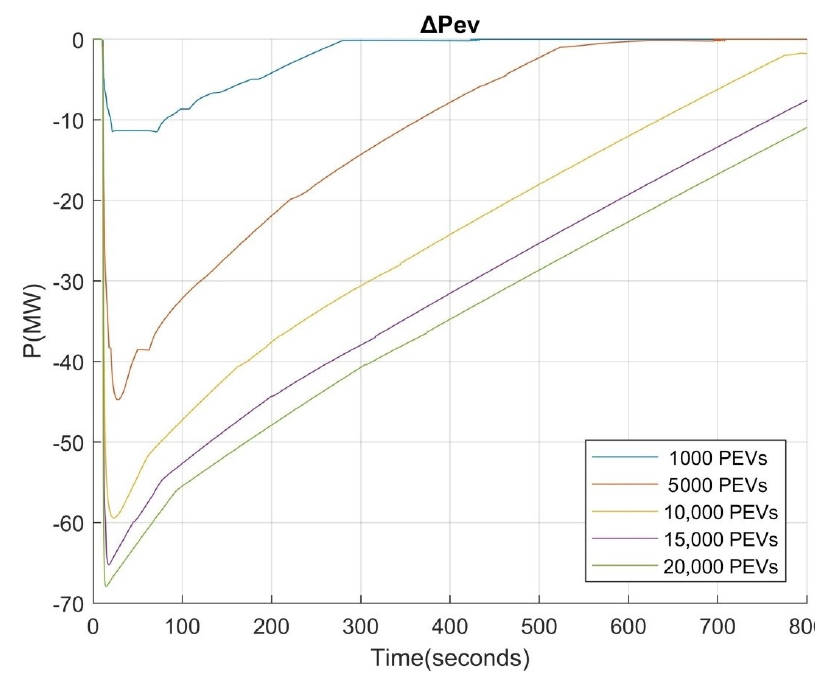
Figure 12. PEV power change with respect to their number (load convention).